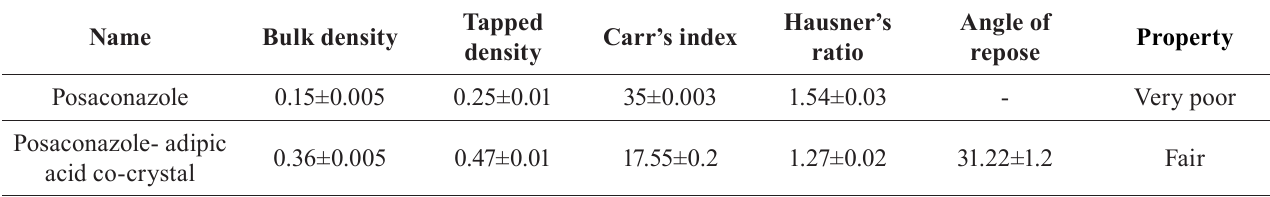
TABLE II - Flow properties of posaconazole and posaconazole-adipic acid co-crystal